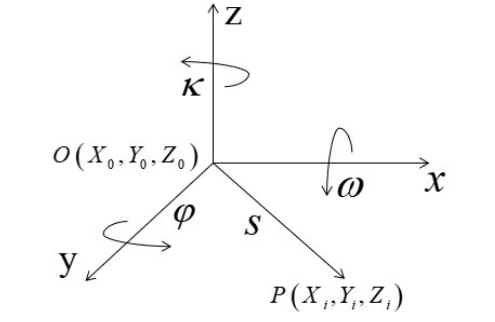
Figure 1. Localization principle of LiDAR